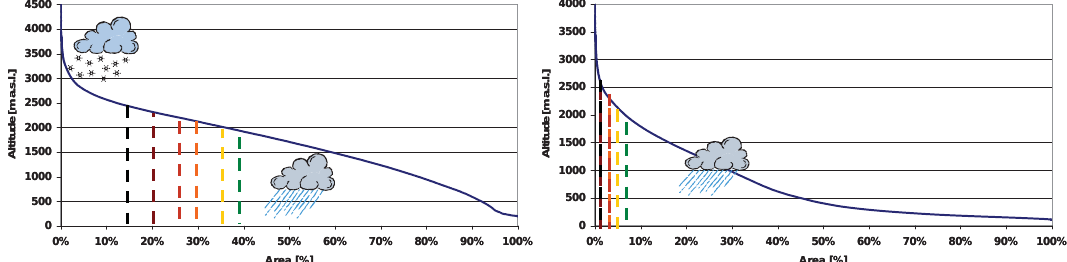
Fig. 9. Ipsographic curve for the Toce (left) and Sesia (right) watershed. The green dashed line refers to the actual snow line located at about 1900–2000ma.s.l., while the other coloured dashed lines refer to the rising of the snow line due to an artificial increase in temperature at 0.5 ◦ C intervals. The plots correlate the total contributing area to the basin altitude. In standard atmosphere conditions the temperature lapse rate is 0.65 ◦ C per 100m, which is the same value used in the FEST-WB model.